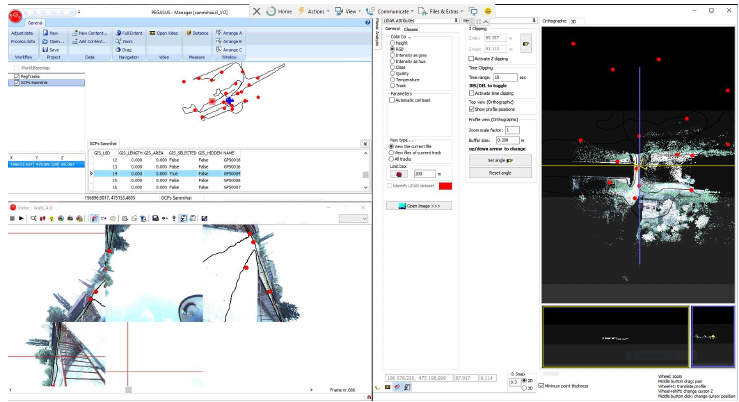
Figure 16. Automatically open of the video catalog for Sânmihaiu Român.